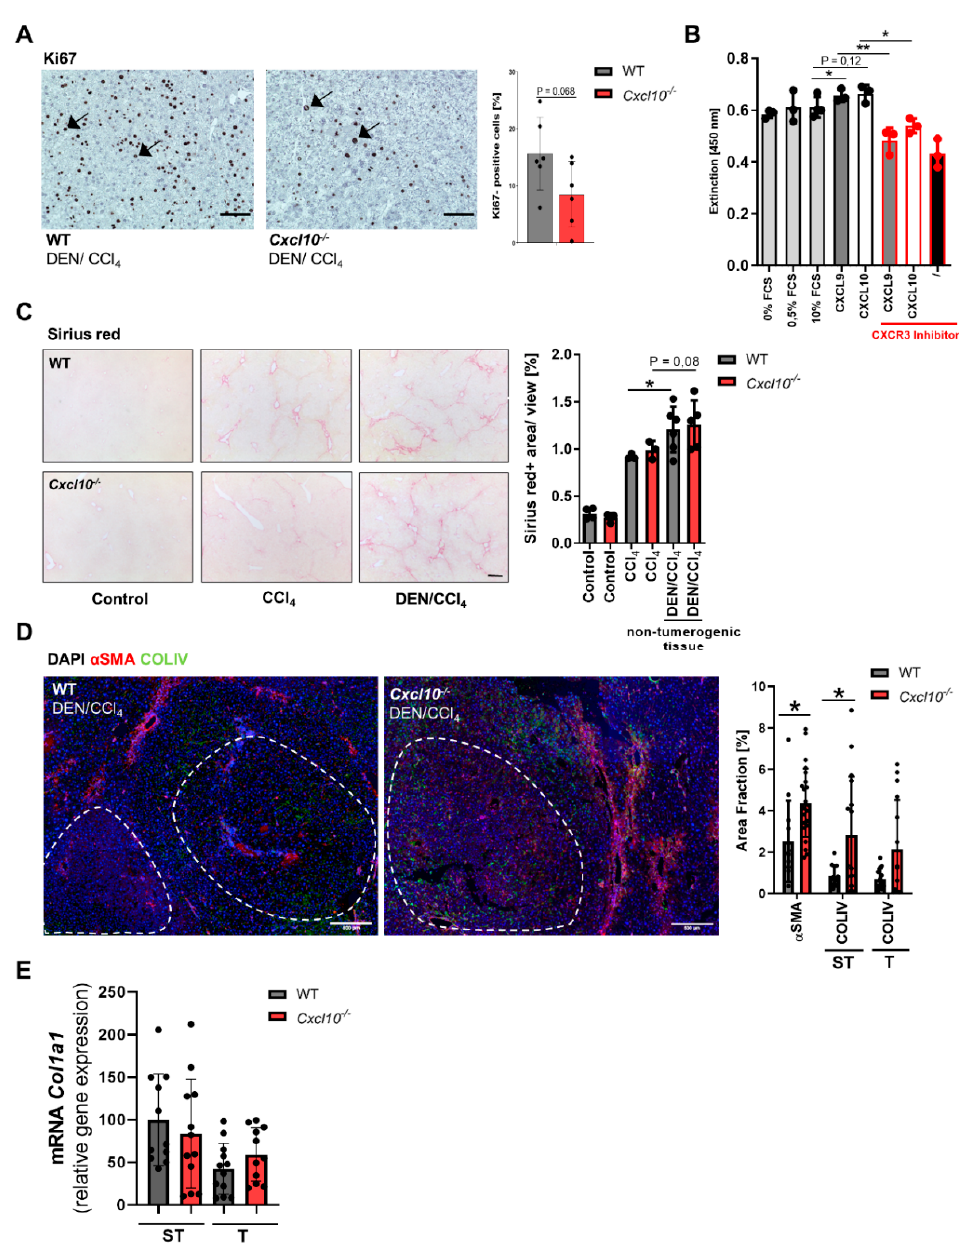
Figure 2. Genetic deletion of Cxcl10 is associated with a reduced tumor cell proliferation and contributed to a rearrangement of the tumorigenic extracellular matrix composition: ( A ) Ki-67 staining of tumor-bearing livers from WT and Cxcl10 − / − mice; exemplary pictures of Ki-67-stained liver tissue of both genotypes (scale bar 200 µ m); arrows: Ki-67+ tumor cells. The percentage of Ki-67+ cells/view field was determined. Three view fields were counted per sample; ( B ) human hepatoma cell line (HUH7) (n = 3) was stimulated with CXCL9 or CXCL10. Additionally, a CXCR3 inhibitor was added. Positive control: 0%, 0.5% and 10% FCS. After stimulation, a BrdU assay was performed, absorbance at 450 nm = proportional to proliferation rate; ( C ) representative Sirius red stainings of 26 wk old